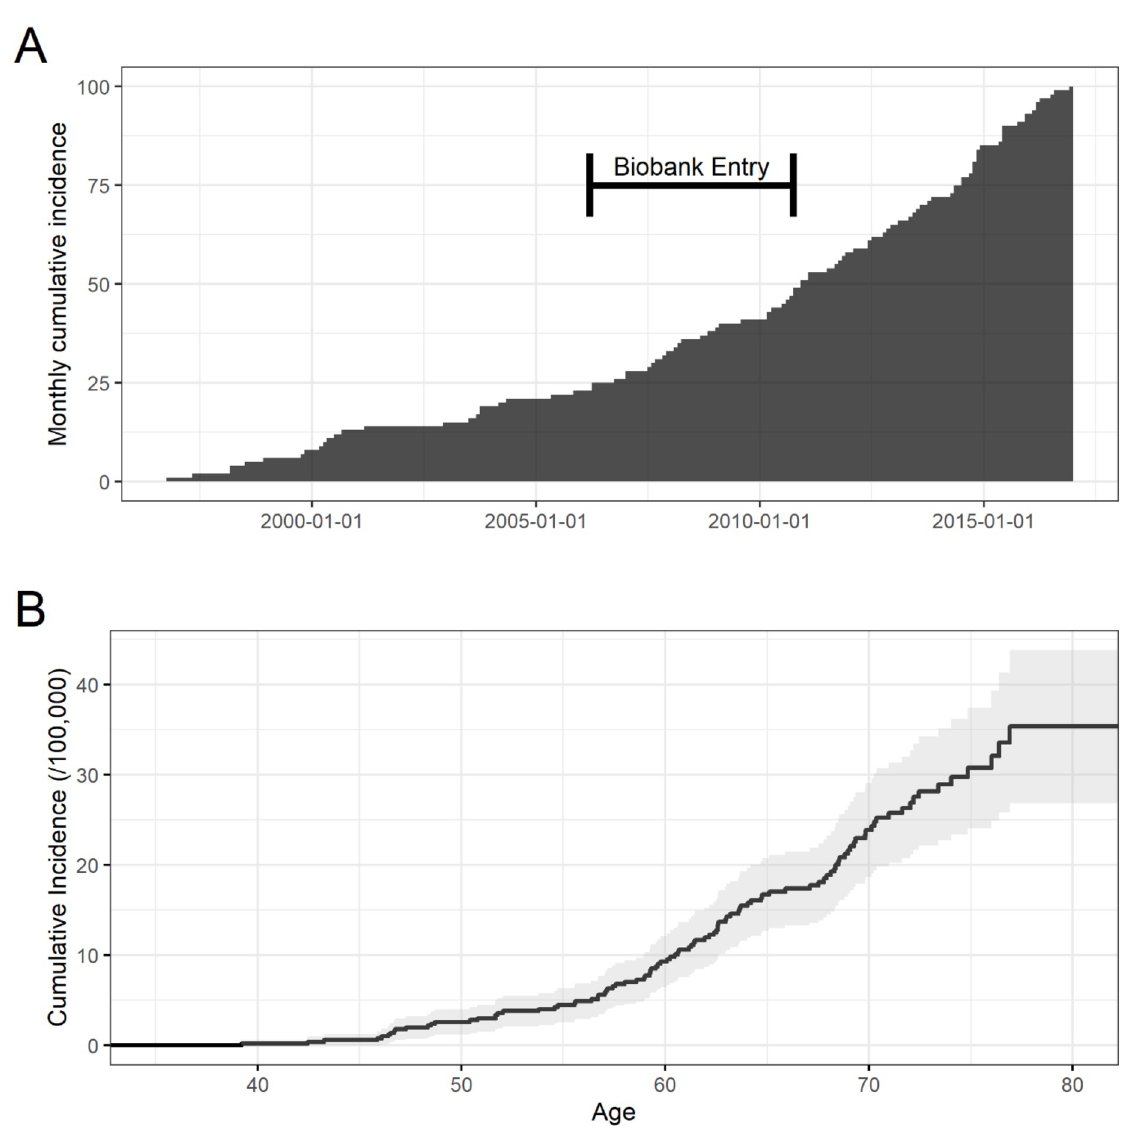
Fig 1. Monthly cumulative incidence of MN. A) Cases identified each calendar month B) Kaplan-Meier estimate by age with